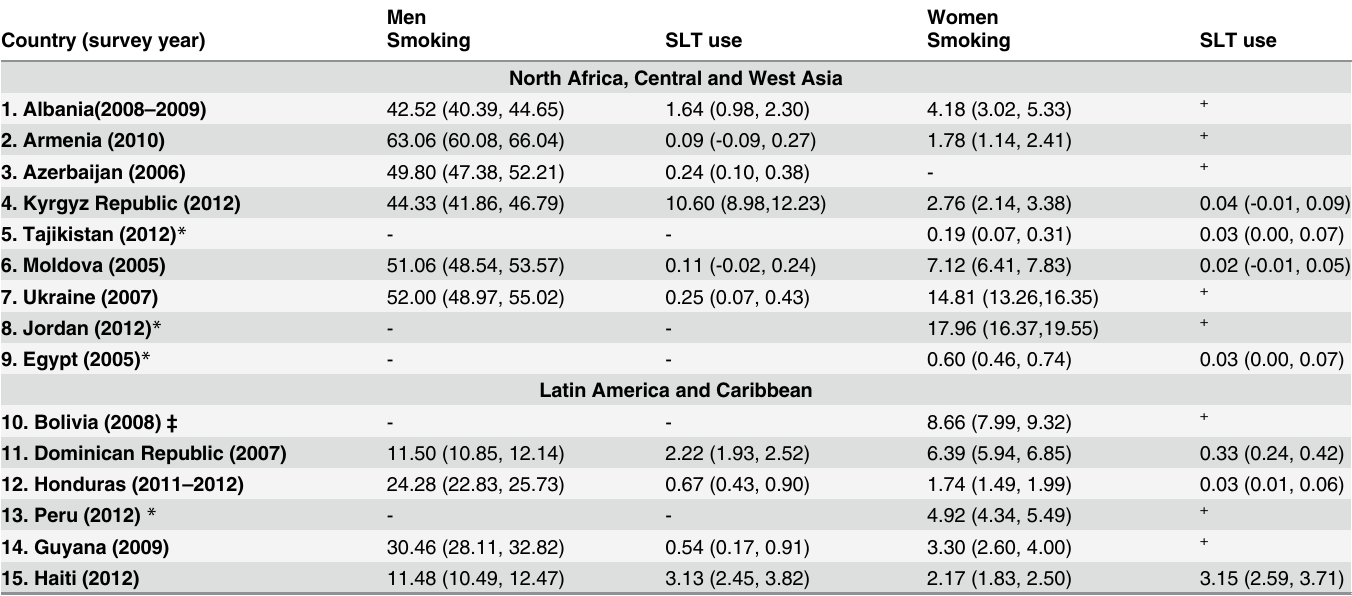
Table 2. Weighted prevalence estimates (95% confidence intervals) of smoking (cigarettes, pipe and others) and smokeless tobacco use (chew- ing, snuff) among men and